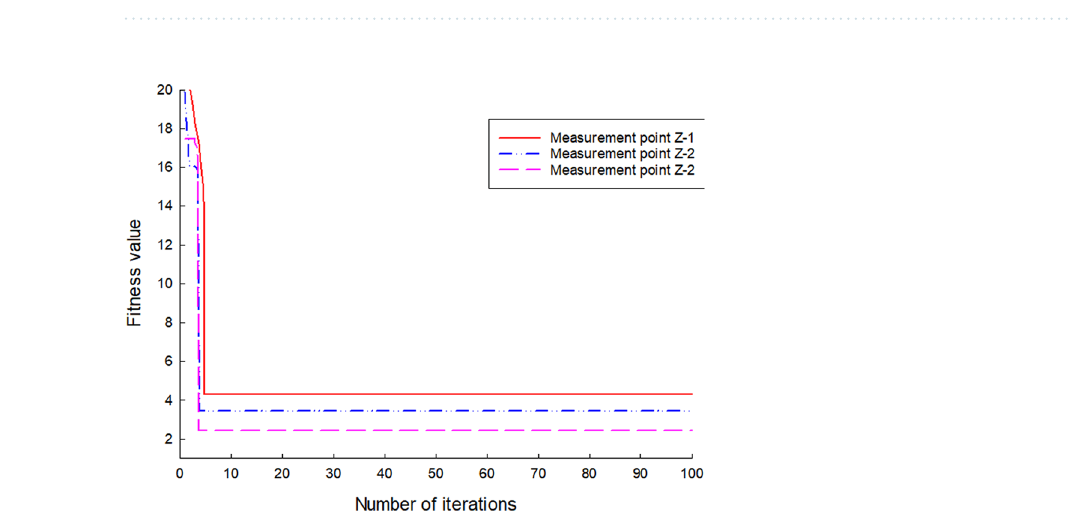
Table 3. Data set of longitudinal measuring points.